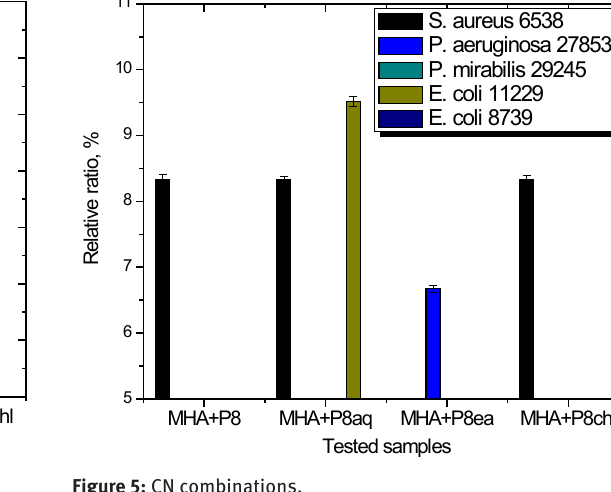
Figure 2: TE combinations.